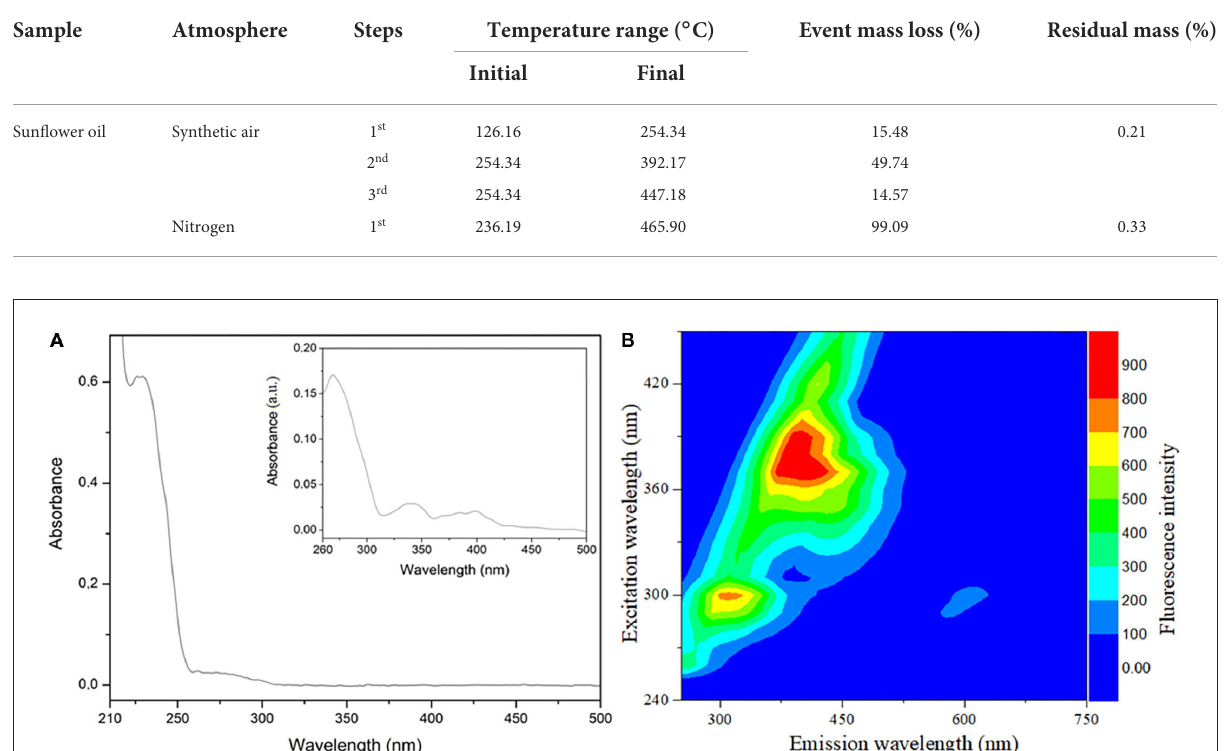
TABLE 4 TGA/DTG curves of sunflower oil obtained under synthetic air and nitrogen atmospheres.